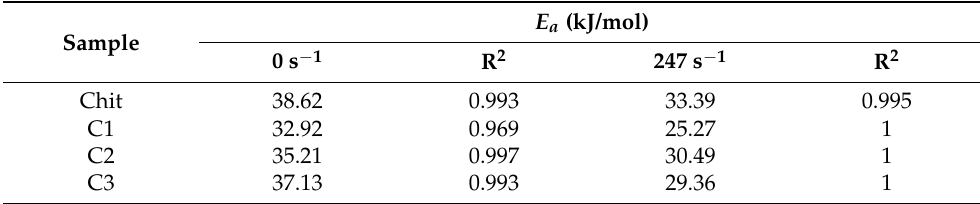
Table 2. E a values of Chit solution and Chit/clay mixtures at various shear rates.